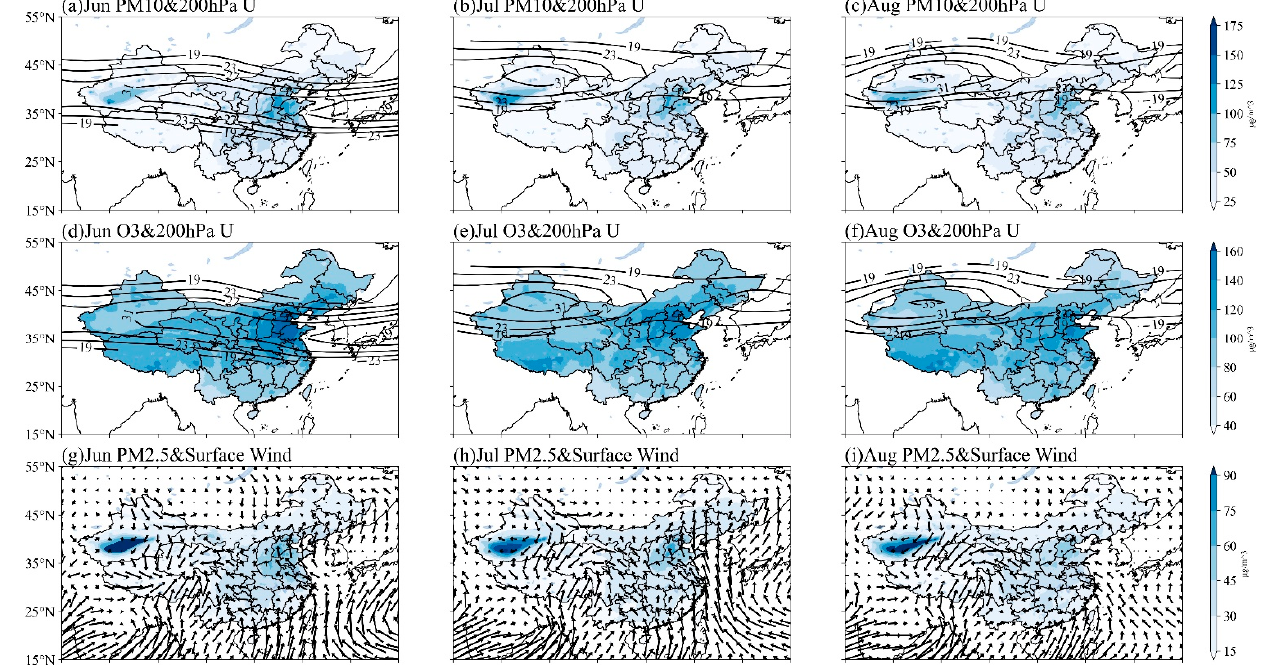
Figure 8. Variations of the 200 hPa westerly jet stream (unit: m · s − 1 , a – f , contours), distributions of the monthly mean surface air pollutants (unit: µ g · m − 3 , including PM 10 , O 3 and PM 2.5 ) and 1000 hPa wind fields (unit: m · s − 1 , g – i , vectors) in June, July and August from 2013 to 2018. The PM 10 , O 3 , PM 2.5 are plotted in shaded in a – c , d – f , g – i , respectively.